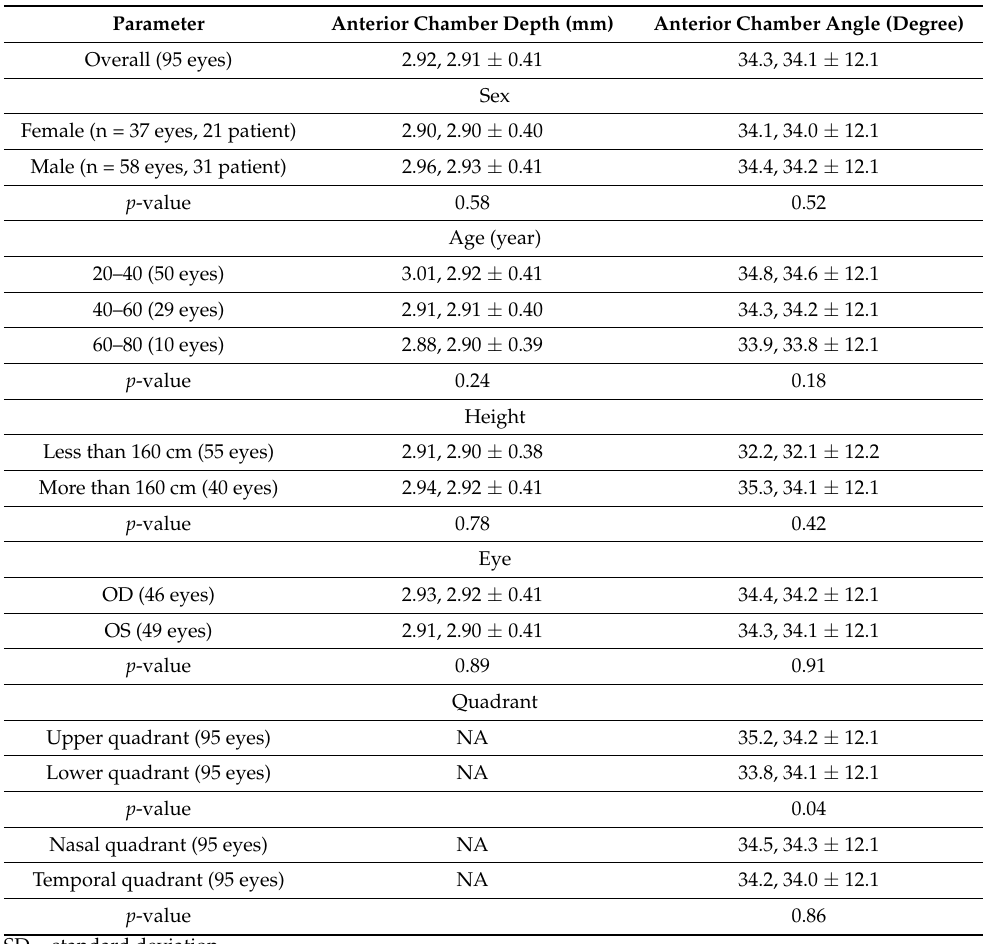
Table 1. The impact of demographics, eye side, and the quadrant of the eye on the anterior chamber angle (ACA) and the anterior segment depth (ASD) in 95 normal